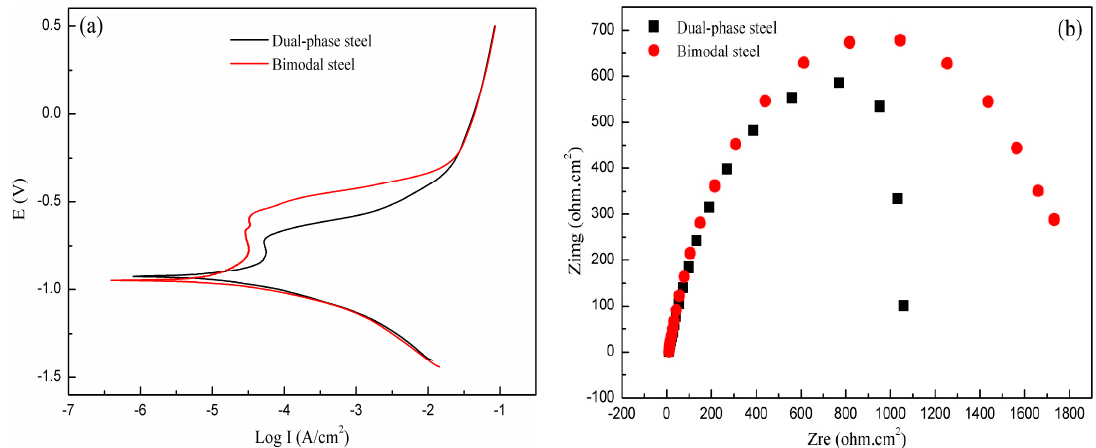
Figure 9. The results of the electrochemistry test: ( a ) polarization curve and ( b ) AC impedance Figure 9. Theresultsoftheelectrochemistrytest: ( a )polarizationcurveand( b spectroscopy.